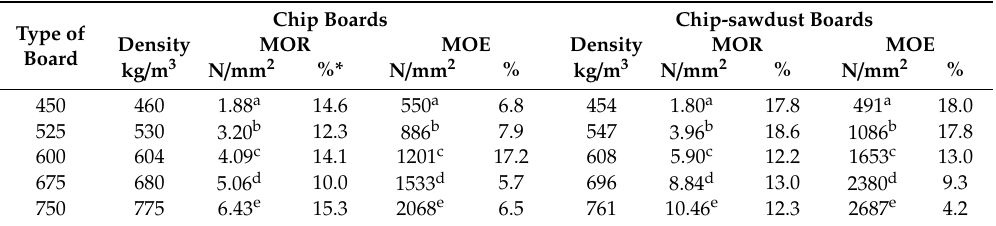
Table 3. Properties of chip and chip-sawdust boards determined in a bending